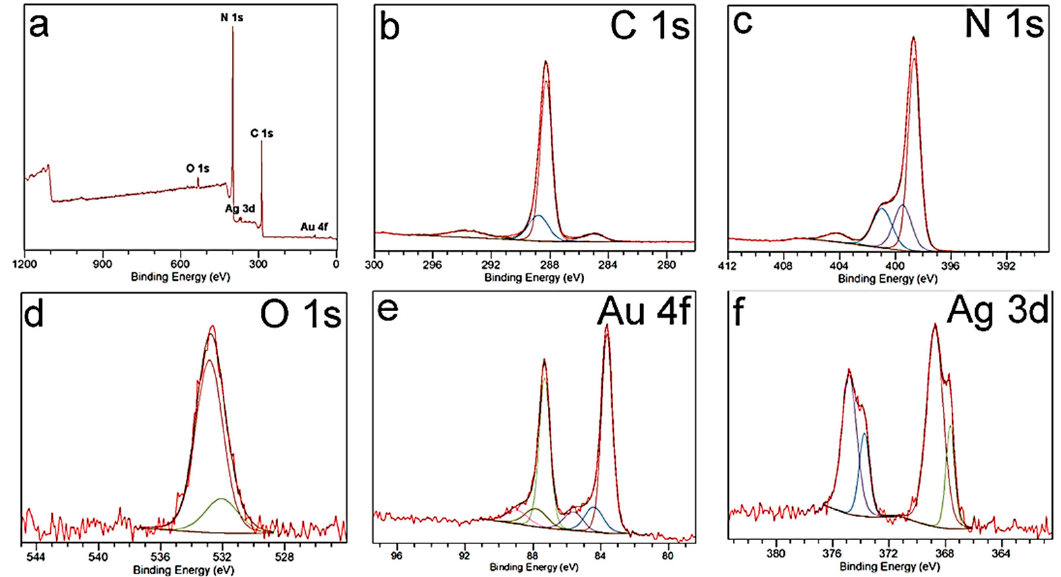
Figure 4. XPS analysis of AuAg loaded g-C 3 N 4 nanomaterials ( a ). XPS Full survey, high-resolution of C 1s ( b ), N 1s ( c ), O 1s ( d ), Au 4f ( e ) and Ag 3d ( f ) [40].